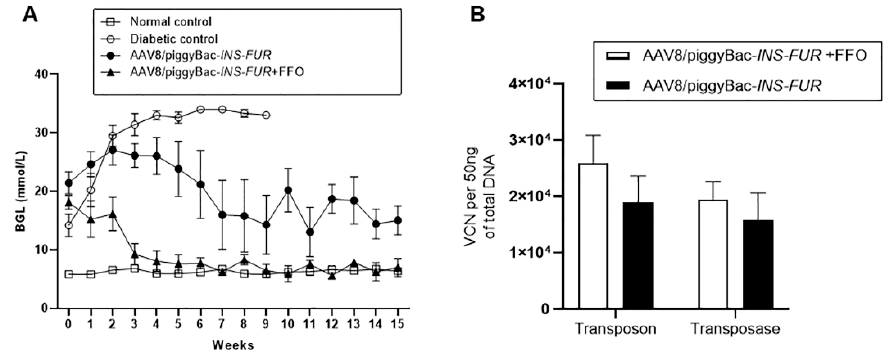
Figure 4. Blood glucose levels and AAV8 vector copy numbers of NOD mice after piggyBac / AAV8-mediated expression of INS-FUR and INS-FUR combined with the FFO surgical procedure. Diabetic NOD mice were transduced with either INS-FUR or INS-FUR in combination with the FFO surgical procedure at 7 days after transduction. ( A ) The mean weekly blood glucose levels of untreated diabetic (n = 7), normal, non-diabetic (n = 7) and treated diabetic NOD mice that received either i.p. injections of AAV8- piggyBac / INS-FUR -mCherry (n = 7) alone, or AAV8- piggyBac / INS-FUR -mCherry with FFO surgery (n = 7). ( B ) Transposon and transposase copy numbers of diabetic NOD mice that received i.p. injections of AAV8 / piggyBac - INS-FUR or i.p. injection of AAV8 / piggyBac - INS-FUR and FFO sugery. The results are expressed as the means ± SEMs.